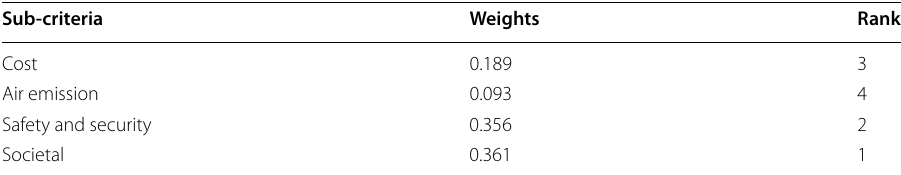
Table 15 The sub criteria